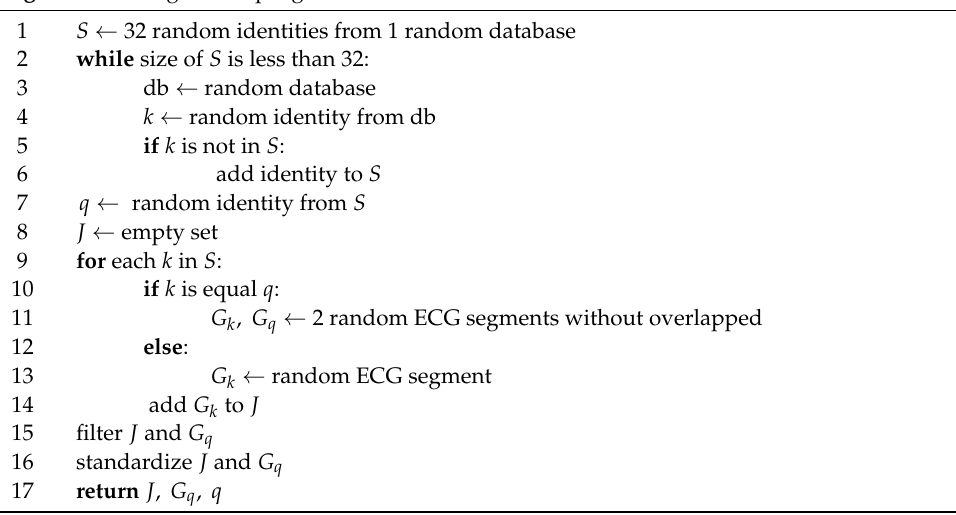
Algorithm 1. Single example